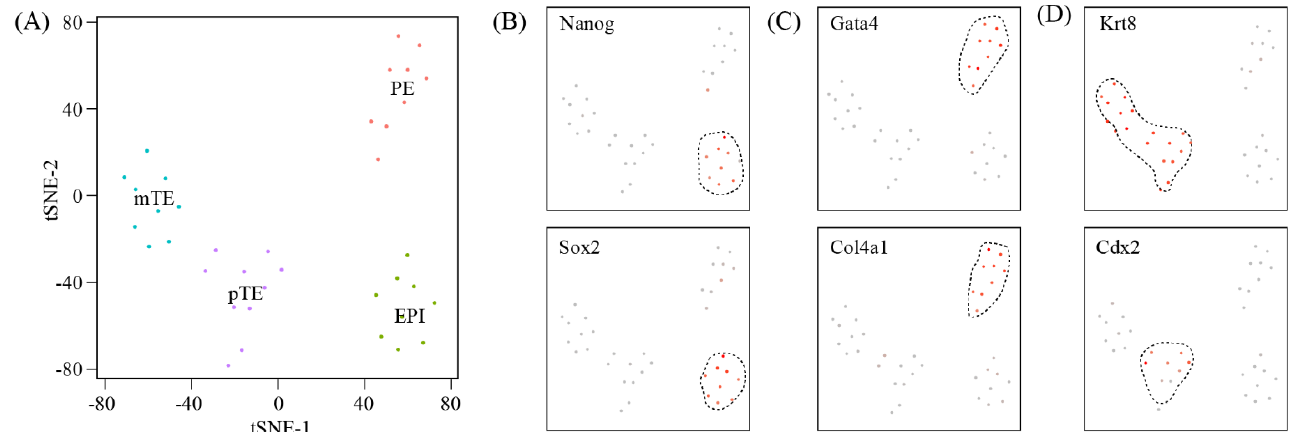
Figure 4. A single-cell atlas of E4.5 embryos: ( A ) TSNE clustering of single cells from mouse E4.5 blastocysts which were collected from GD5 uteri from a previous study. EPI: epiblast; PE: primitive endoderm; mTE: mural trophectoderm; pTE: polar trophectoderm. ( B – D ) TSNE plots showing the expression pattern of canonical marker genes for EPI ( B ), PE ( C ) and mTE/pTE ( D ). Dashed lines show the boundaries of the specific cell clusters.